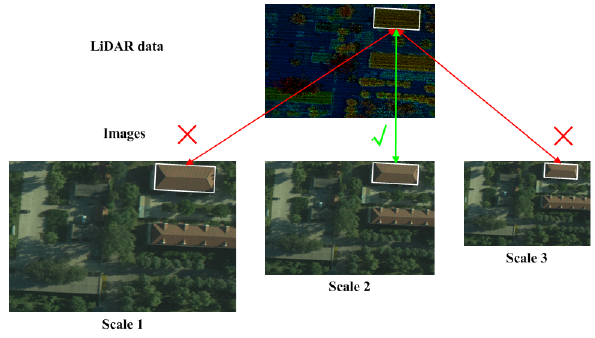
Figure 2: The example image of illustrating the procedure of choosing the optimal scale image to match the LiDAR data.